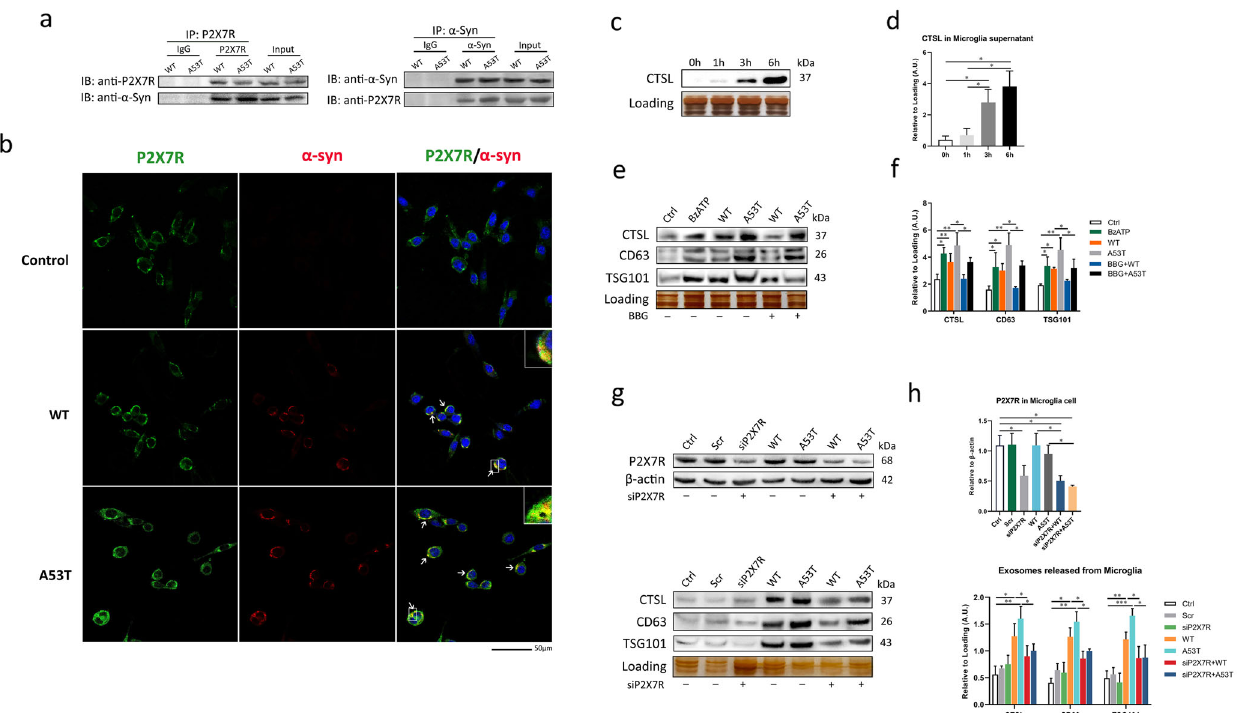
Fig. 3 P2X7R is necessary for the release of CTSL-containing exosomes from α -Syn oligomers-treated microglia. a Extracellular α -Syn oligomer interacts with P2X7R. Western blot analysis of α -Syn expression in microglia after treatment with WT or A53T α -Syn oligomer for up to 6 h. WT and A53T α -Syn oligomer were coimmunoprecipitated with P2X7R, with A53T α -Syn oligomer showing a stronger interaction. b Representative confocal microscopy images of immuno fl uorescence staining for α -Syn (red) and P2X7R (green) after treatment with A53T or WT α -Syn oligomer for up to 6 h to observe colocalization (indicated by arrows). Scale bar: 50 μ m. c , d Western blot and quantitative analysis of CTSL release from the supernatant of microglia stimulated with BzATP (100 μ M), an agonist of P2X7R, for up to 6 h ( n = 4); * p < 0.05. e , f